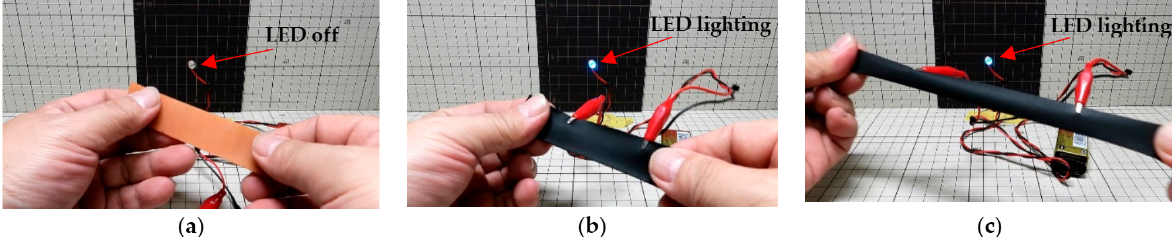
Figure 2. Ultraflexible, thin film electrode formation with CNT spray: ( a ) Before applying the CNT spray; ( b ) After applying the CNT spray; ( c ) Even when stretched greatly, the LED remains on and the LED lights